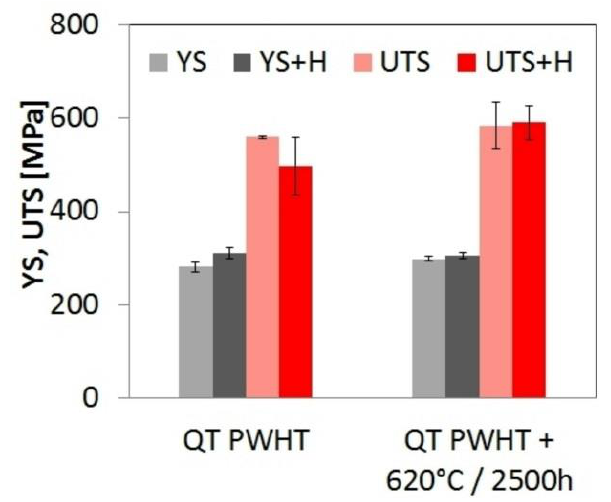
Figure 7 . Effects of isothermal aging at 620 °C and electrochemical hydrogen charging on the room- temperature strength properties of T92/TP316H dissimilar weldments (YS — yield stress, UTS — ultimate tensile strength).